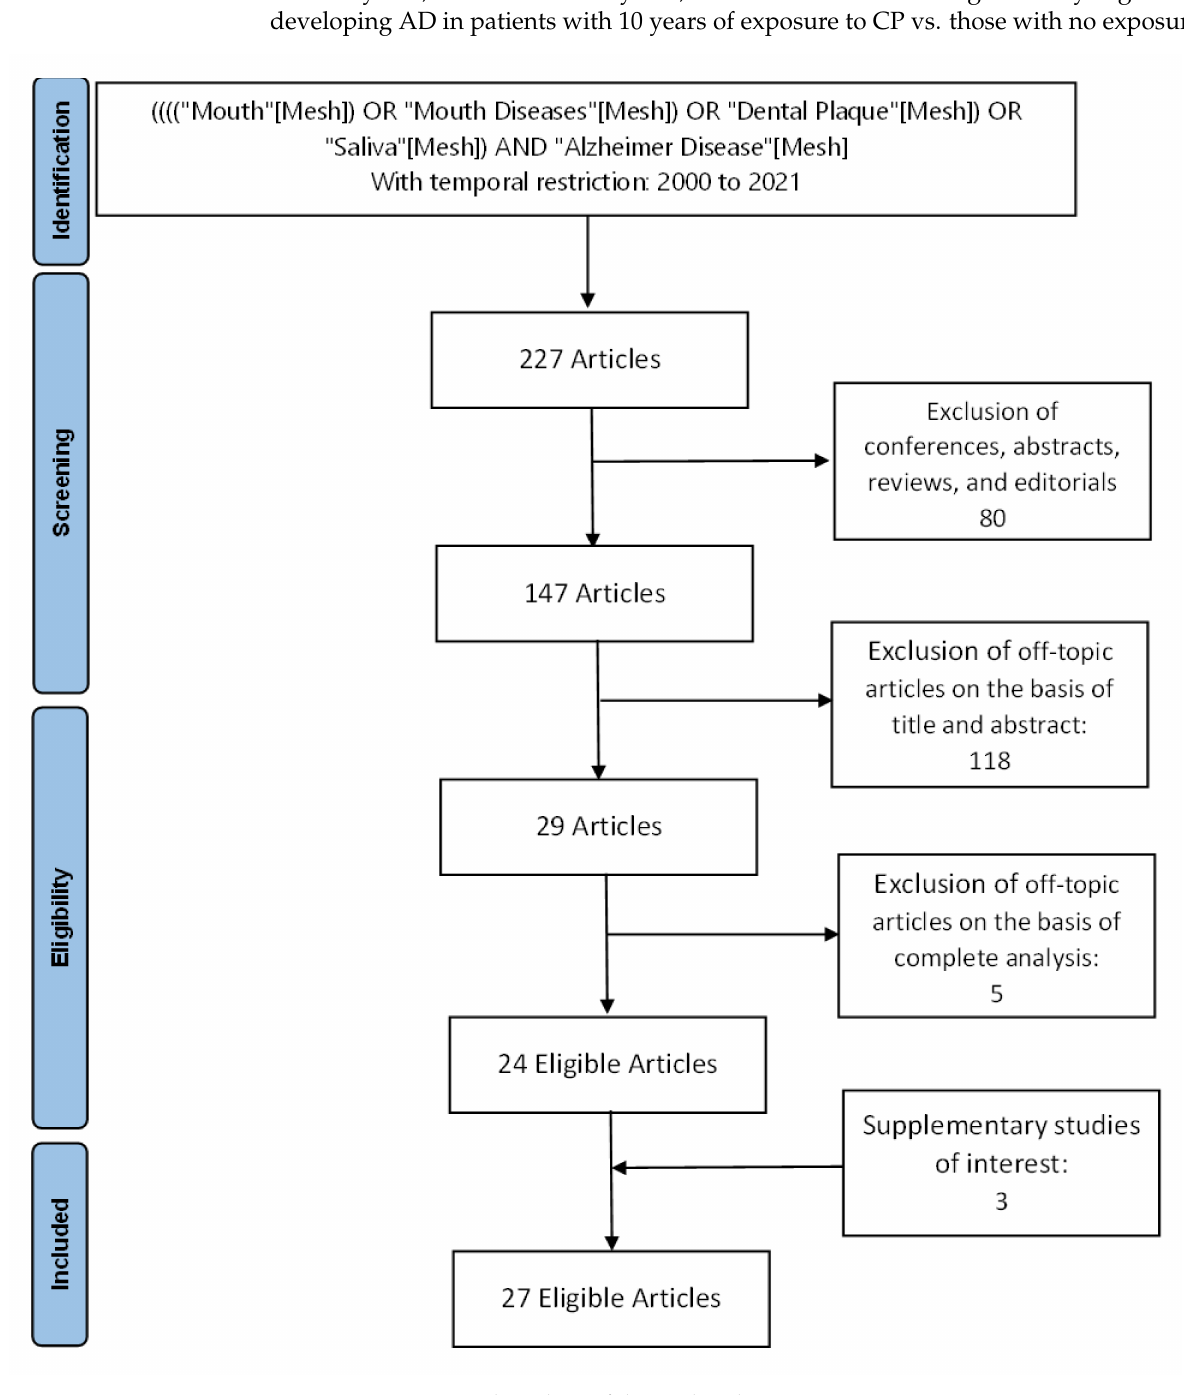
Figure 1. Flow chart of the study